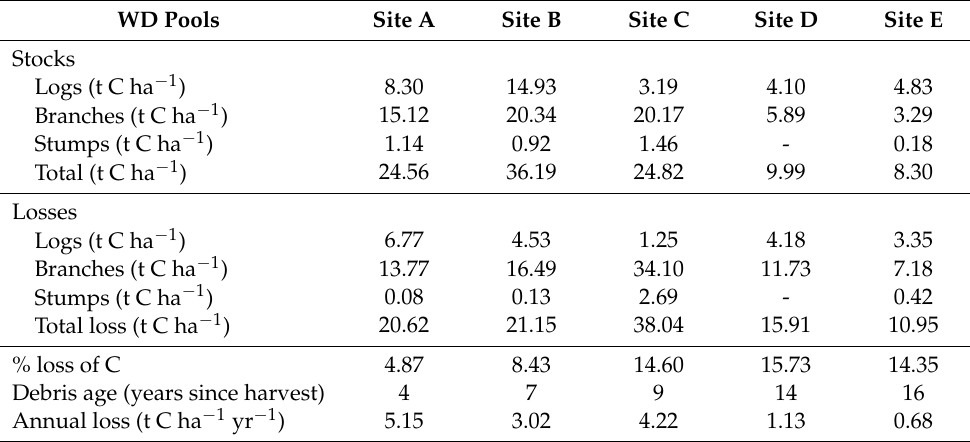
Table 3. Current WD stocks (t C ha − 1 ) and losses (t C ha − 1 ) along the 16-year